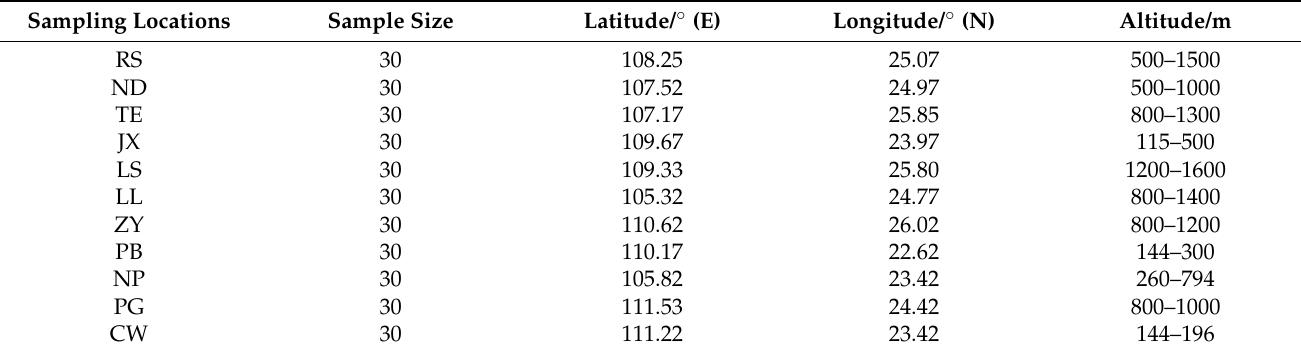
Table 1. Information on samples and sampling locations.